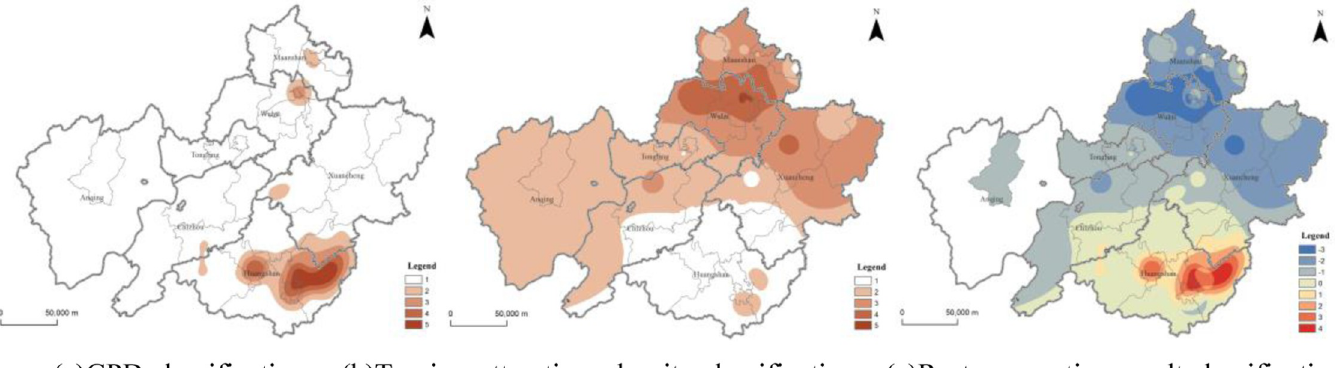
Fig 7. Analysis of tourist attractions and GDP factors in the demonstration region. Contains information from OpenStreetMap and OpenStreetMap Foundation, which is made available under the Open Database License. (a) GPD classification. (b) Tourism attractions density classification. (c) Raster operation result